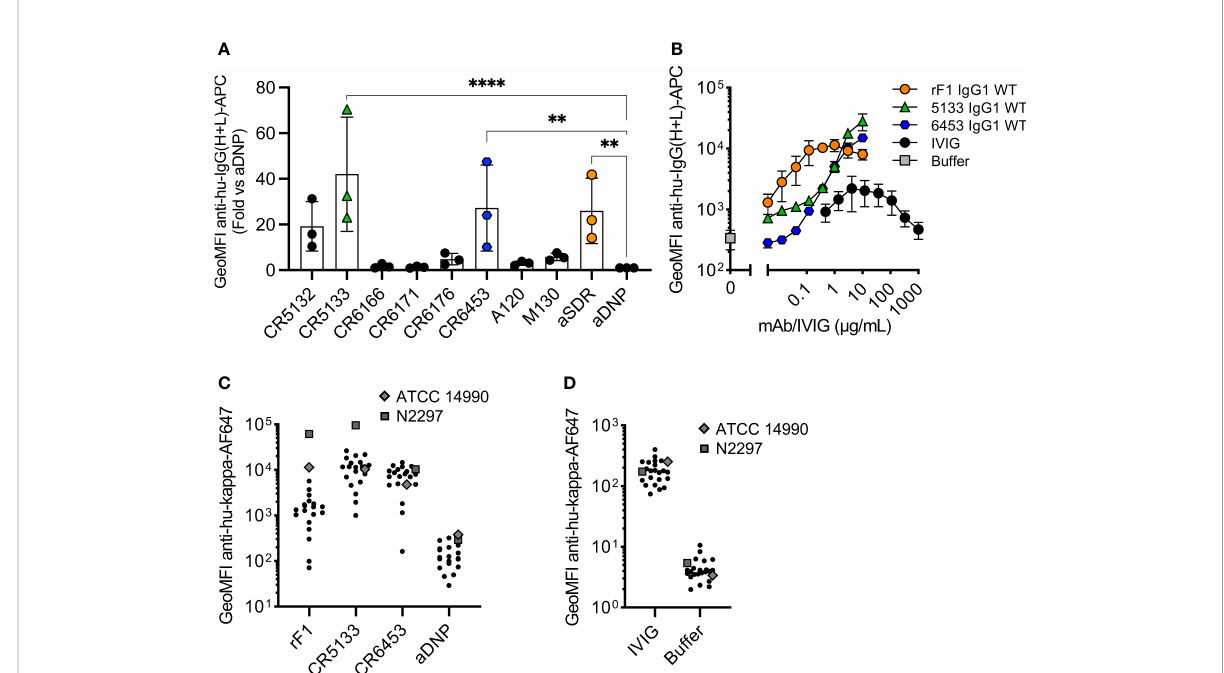
FIGURE 1 Identifying mAbs that bind S. epidermidis neonate isolates. (A) Screening mAb binding to S. epidermidis ATCC 14990. Bacteria were incubated with 2 µg/mL IgG1. MAb binding was detected using goat anti-hu-IgG(H+L)-APC and using fl ow cytometry. Data represent GeoMFI ± SD normalized to aDNP (ctrl)-IgG1 of three independent experiments. One-way ANOVA followed by Dunnett test was performed to test for differences in antibody binding versus aDNP and displayed only when signi fi cant as **P ≤ 0.01 and ****P ≤ 0.0001. (B) Titration of binding mAbs. FITC labelled ATCC 14990 were incubated in a 3-fold dilution range from 1000 µg/mL for IVIG and from 10 µg/mL for rF1-IgG1, CR5133-IgG1 or CR6453-IgG1. MAb binding detected with donkey anti-hu-IgG(H+L)-APC and analysed with fl ow cytometry. Data represent GeoMFI ± SD of three independent experiments. Histograms of fl ow cytometry analysis are included in Figure S2. (C) IVIG binding to clinical isolates. 20 clinical isolates and ATCC 14990, were incubated with 25 µg/mL IVIG. IVIG binding was detected with goat anti-hu-kappa-AF647. Data points are represented as mean AF647 GeoMFI of one experiment. (D) mAb binding to clinical isolates. 20 clinical isolates and ATCC 14990,